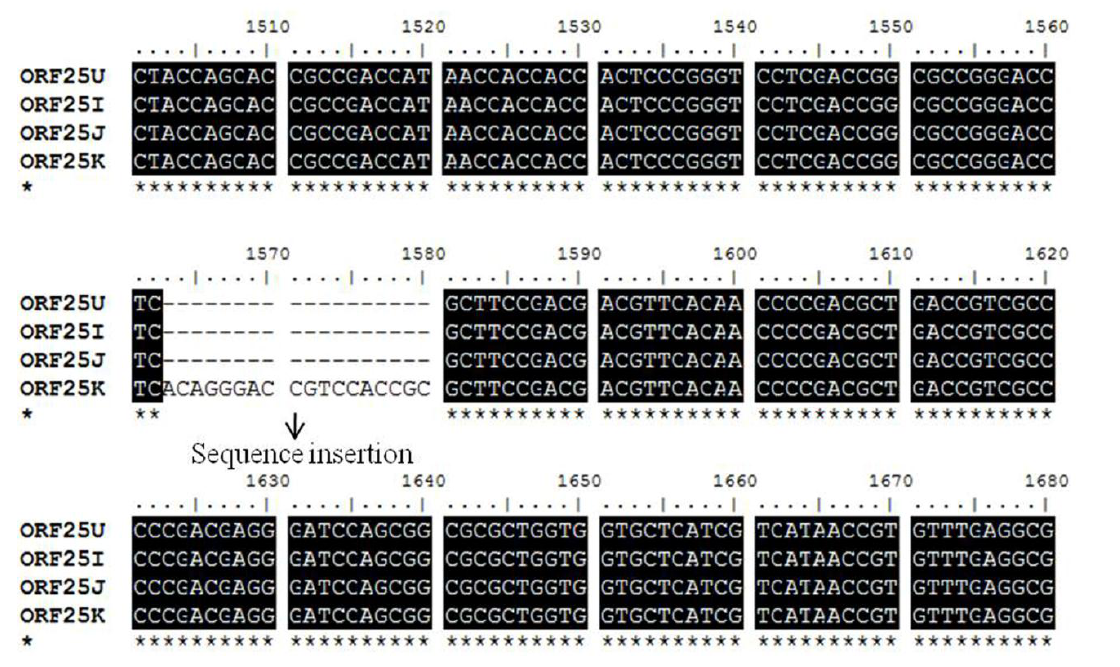
Figure 1. Nucleotide sequences of the glycoprotein gene (open reading frame [ORF]25) of the Korean CyHV-3 (KHV-K) and those of the USA (KHV-U), Israel (KHV-I), and Japan (KHV-J) CyHV-3 were aligned using BioEdit software. A sequence insertion (18 bp) was observed in Korean CyHV-3